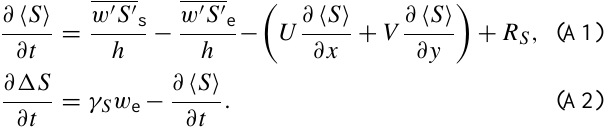
The dependence of the subsidence velocity on height is presented in (b) .